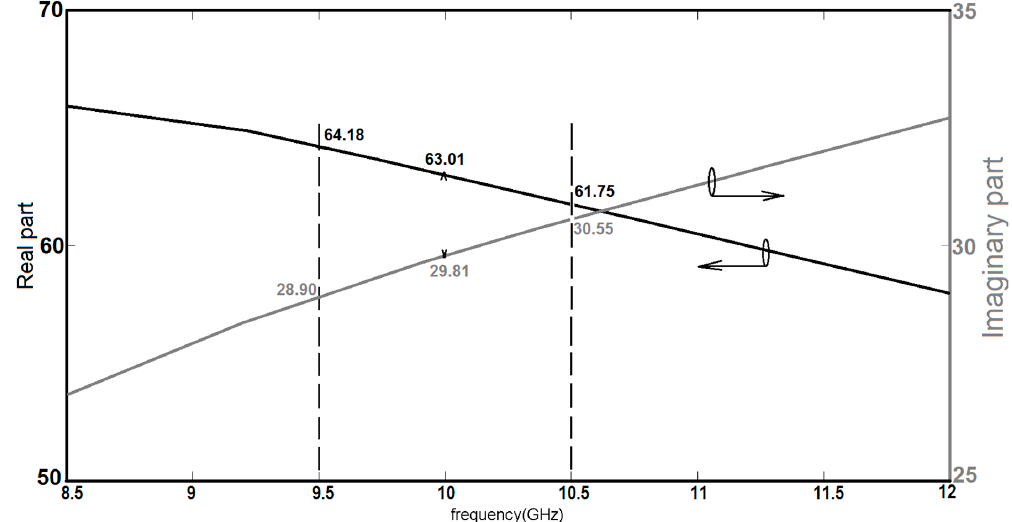
Figure 3. The real and imaginary part of permittivity for pure water at 25 °C.